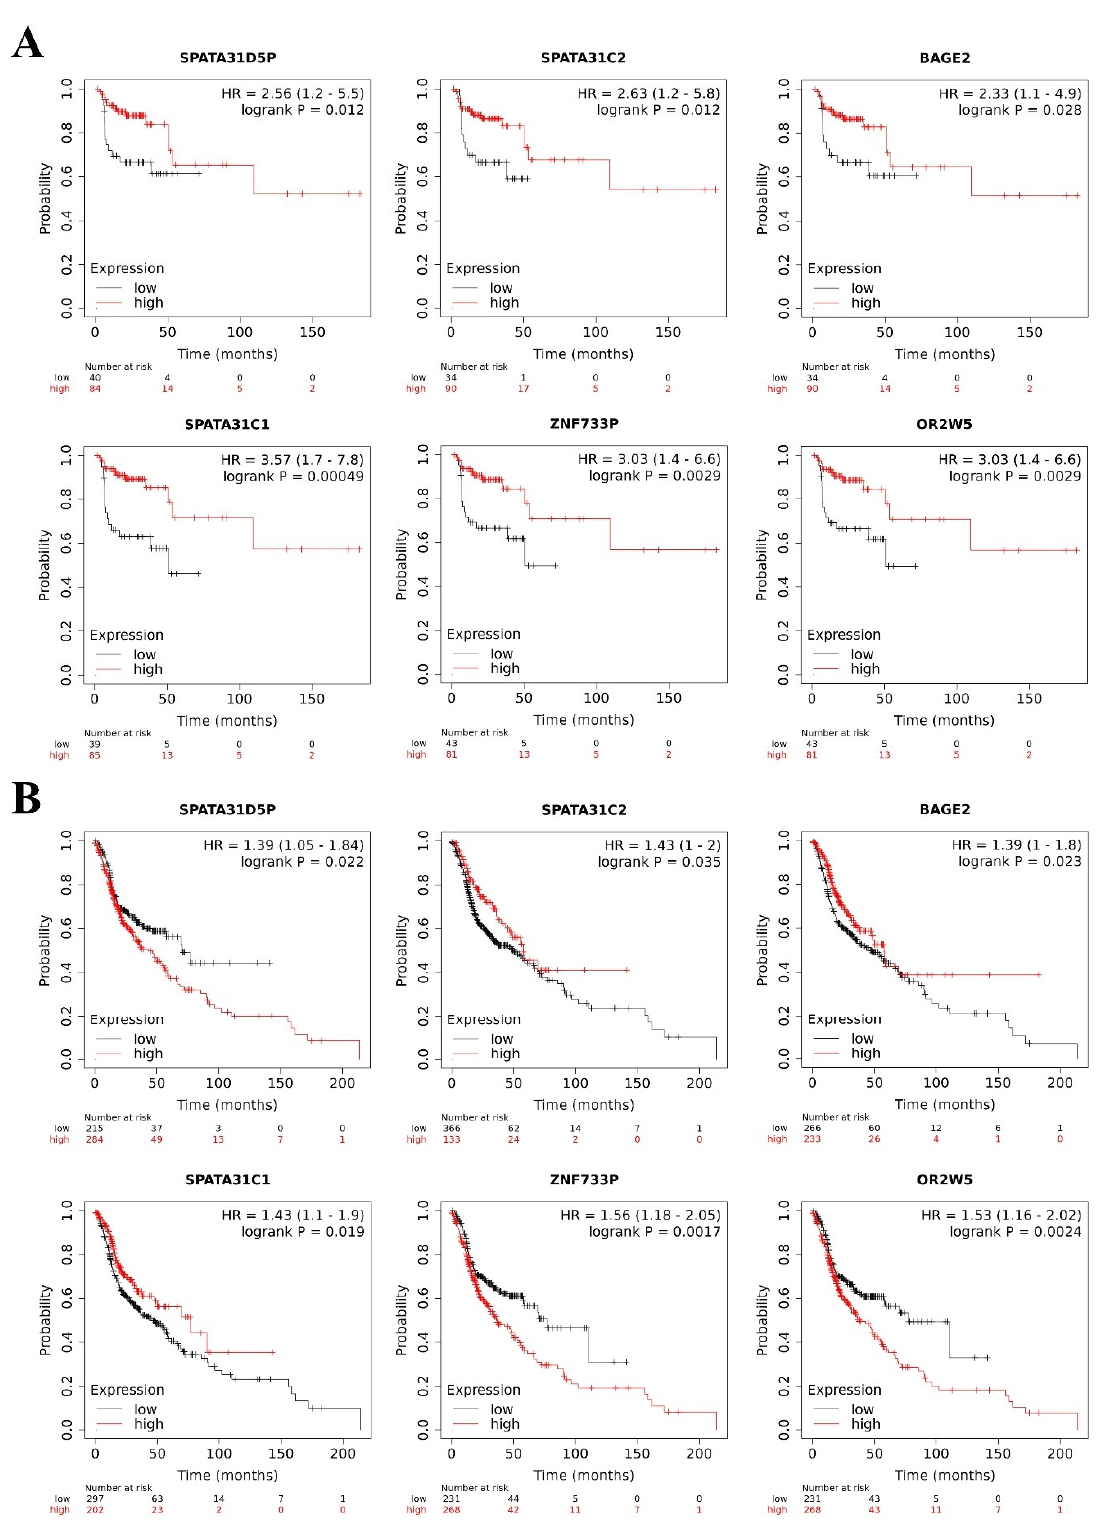
Figure 5. Pseudogene transcripts and head and neck cancer (HNC) patients’ survival. Prognostic value of deregulated pseudogene transcripts in HNC patients by Kaplan–Meier Plotter online database. ( A ) Lower expression of SPATA31D5P , SPATA31C2 , BAGE2, SPATA31C, ZNF733P and OR2W5 pseudogene transcripts indicated worst relapse-free survival in HNC patients. ( B ) Higher expression of SPATA31D5P , ZNF733P , and OR2W5 pseudogene transcripts and lower expression of SPATA31C2 , BAGE2 and SPATA31C1 pseudogene transcripts were associated with worst overall survival of HNC patients.